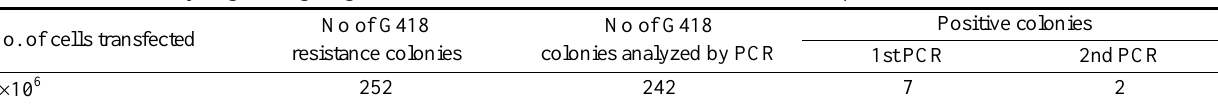
Table 1. The efficiency of gene targeting at the GGTA1 locus with knock-in vector for DAF expression No of G418 No of No. of cells transfected resistance colonies